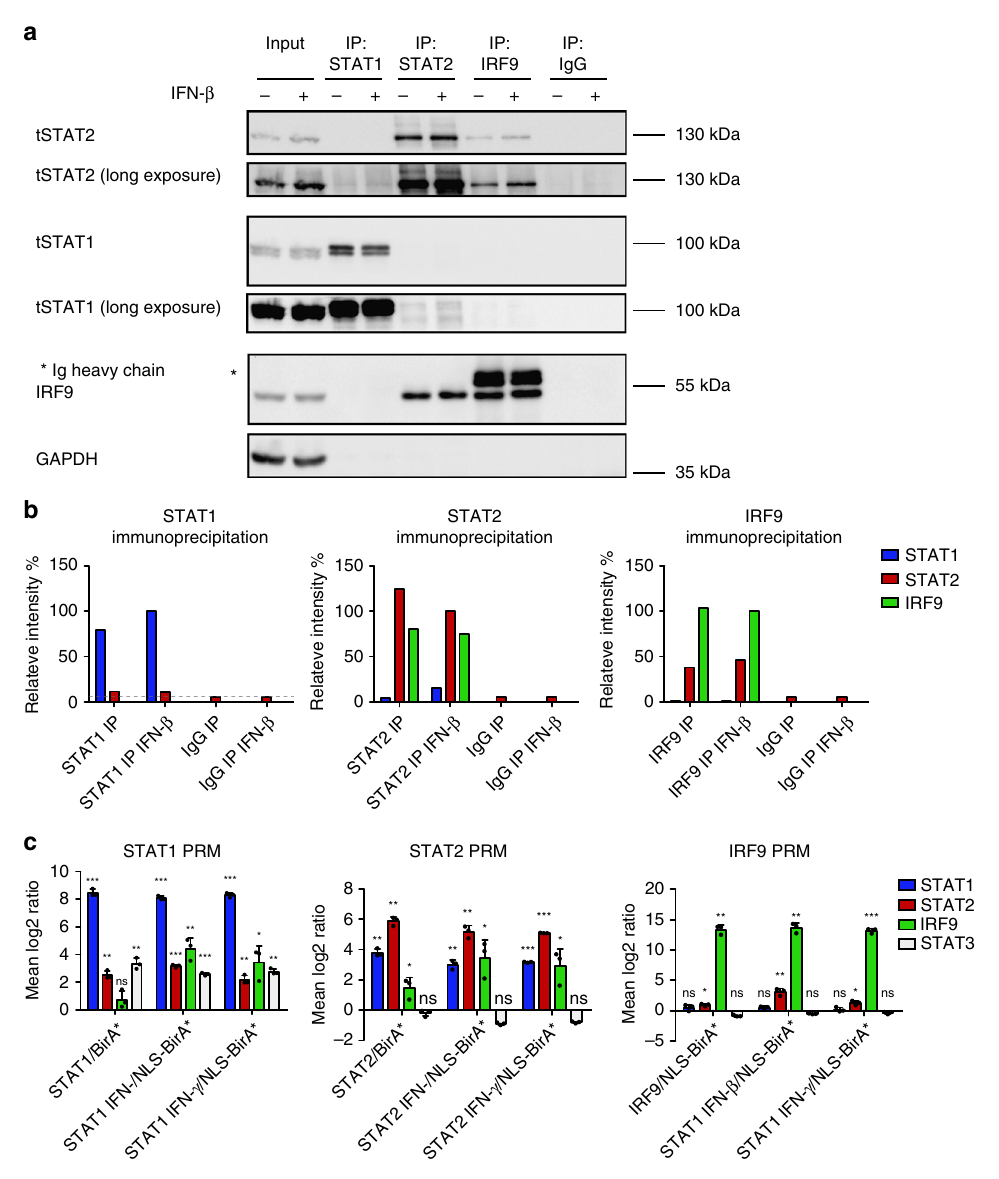
Fig. 4 Signal dependence of complex formation from ISGF3 subunits. a BMDMs from wild-type (WT) animals were treated for 1.5 h with IFN- β and immunoprecipitation was carried out using antibodies against STAT1, STAT2, IRF9, or an IgG control. Immunoprecipitated complexes were analyzed by western blotting with antibodies to STAT1, STAT2, IRF9, and GAPDH. Input controls represent 10% of the total lysate used for the immunoprecipitation. b The representative blot was quanti fi ed using ImageJ software. Relative intensities of the bands were normalized to their corresponding input sample. Data represent relative intensities in percent, where STAT1, STAT2, and IRF9 levels in IFN- β -treated IPs equal 100%. c Targeted quantitative MS analysis of STAT1, STAT2, and IRF9 BioIDs using PRM. Raw 264.7 cells were treated with 0.2 µ g/ml doxycycline for 24 h, followed by addition of 50 µ M biotin for 18 h. Cells were treated for 2 h either with IFN- β or IFN- γ lysed and protein complexes were isolated by streptavidin af fi nity puri fi cation, followed by analysis with LC – MS. Mean log 2 -transformed protein ratios were calculated for three biological replicates of myc-STAT1-BirA*, myc-STAT2-BirA*, or myc-IRF9-BirA* cells normalized to their appropriate localization control. Standard deviation and t -test statistics were calculated for each of the target proteins. P -values (* P ≤ 0.05; ** P ≤ 0.01; *** P ≤ 0.001). Source data are provided as a source data fi endogenous levels of ISGF3 subunits (Supplementary Fig. 5a, c, e) and used cells expressing either N-terminally myc-tagged BirA* or NLS-BirA* genes as controls. The NLS-tagged protein localized to